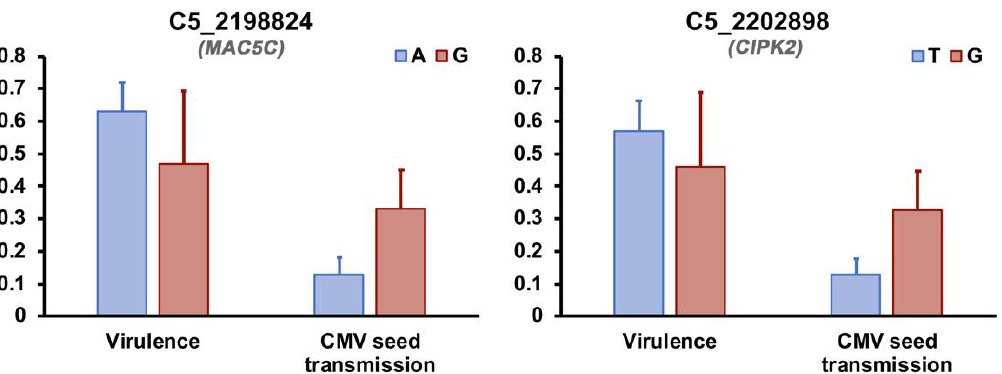
Figure 6. Distribution of CMV virulence and seed transmission rate across Arabidopsis genotypes harboring major (blue) and minor (red) variants of the two SNPs associated with both traits. Letters indicate the nucleotide at each SNP for the major and minor variants. Seed transmission rate is shown as ST /100 to fit in the same scale as virulence. Each SNP is indicated by the chromosome (C) and the position in which it is located, and the corresponding gene is shown in grey.